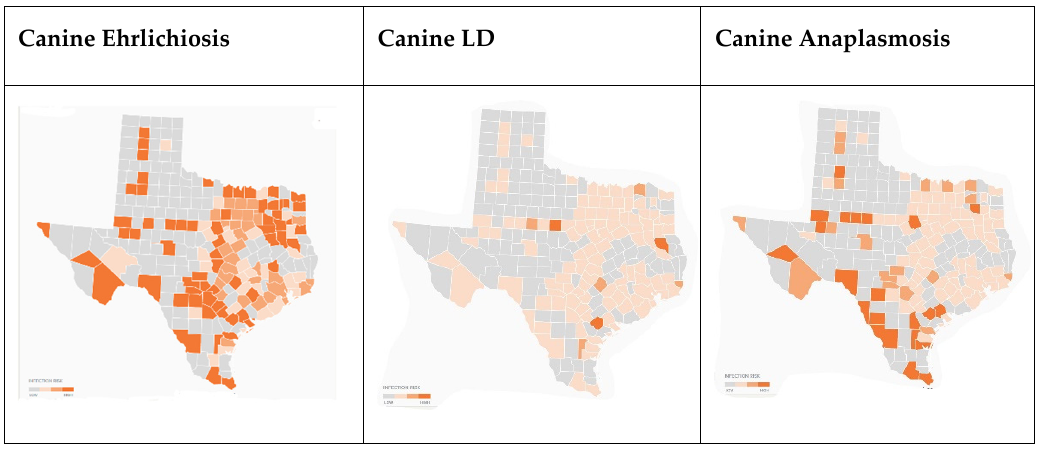
Figure 10. Canine ehrlichiosis, LD, and anaplasmosis by Texas counties (2021) [19] .